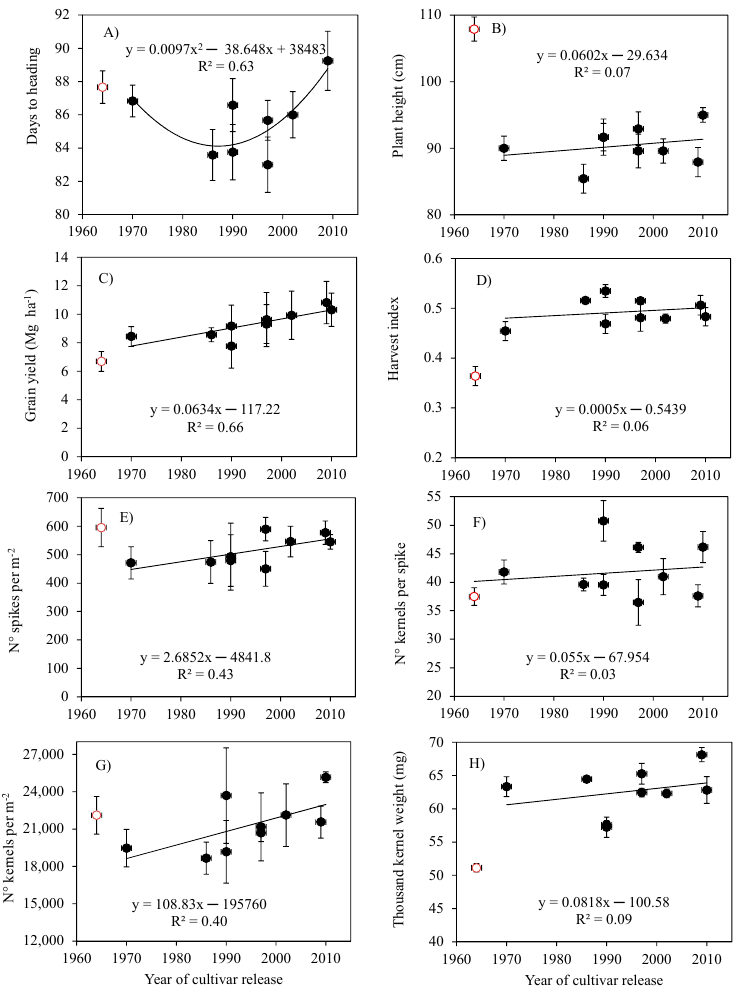
Figure 1. Relationships between the year of release of ten durum wheat cultivars and: Day to heading ( A ), plant height ( B ), grain yield ( C ), harvest index ( D ), number of spikes per square meter ( E ), number of kernels per spike ( F ), number of kernels per square meter ( G ) and thousand kernel weight ( H ). Values correspond to the average ( ± SE) of three growing seasons (2010–2012) except for HI, which was determined in 2010 and 2011. The oldest (1964) cultivar (open circle) was not considered in the regressions. Mean values of cultivars for each year of evaluation are shown in Supplemental Table S2. GY exhibited a positive and linear relationship with the year of cultivar release ( R 2 = 0.66; p < 0.001), this analysis excluding the oldest cultivar (1964; Figure 1C). The rate of increase in GY after